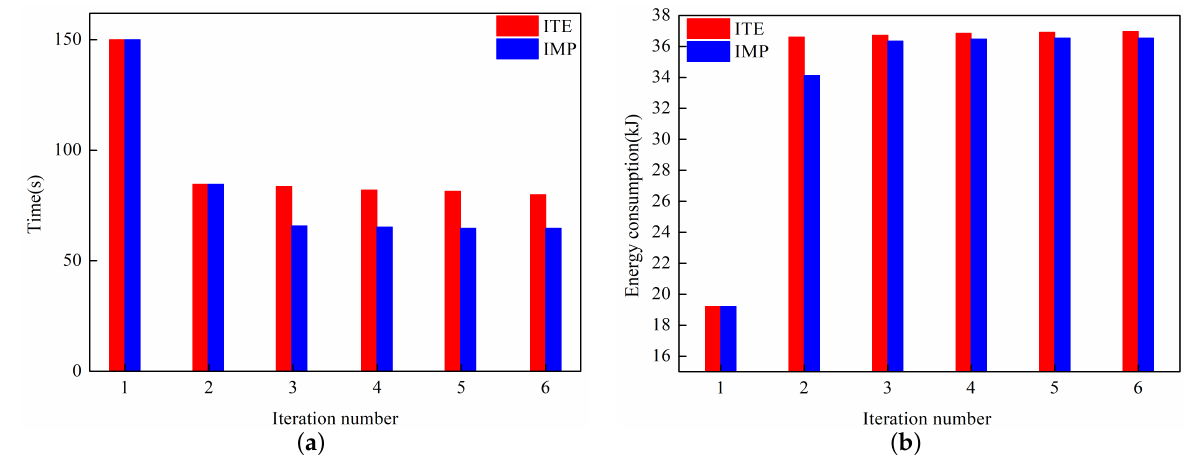
Figure 3. Convergence of ITE algorithm and IMP algorithm. ( a ) Convergence of the two algorithms in time. ( b ) Convergence of the two algorithms in energy